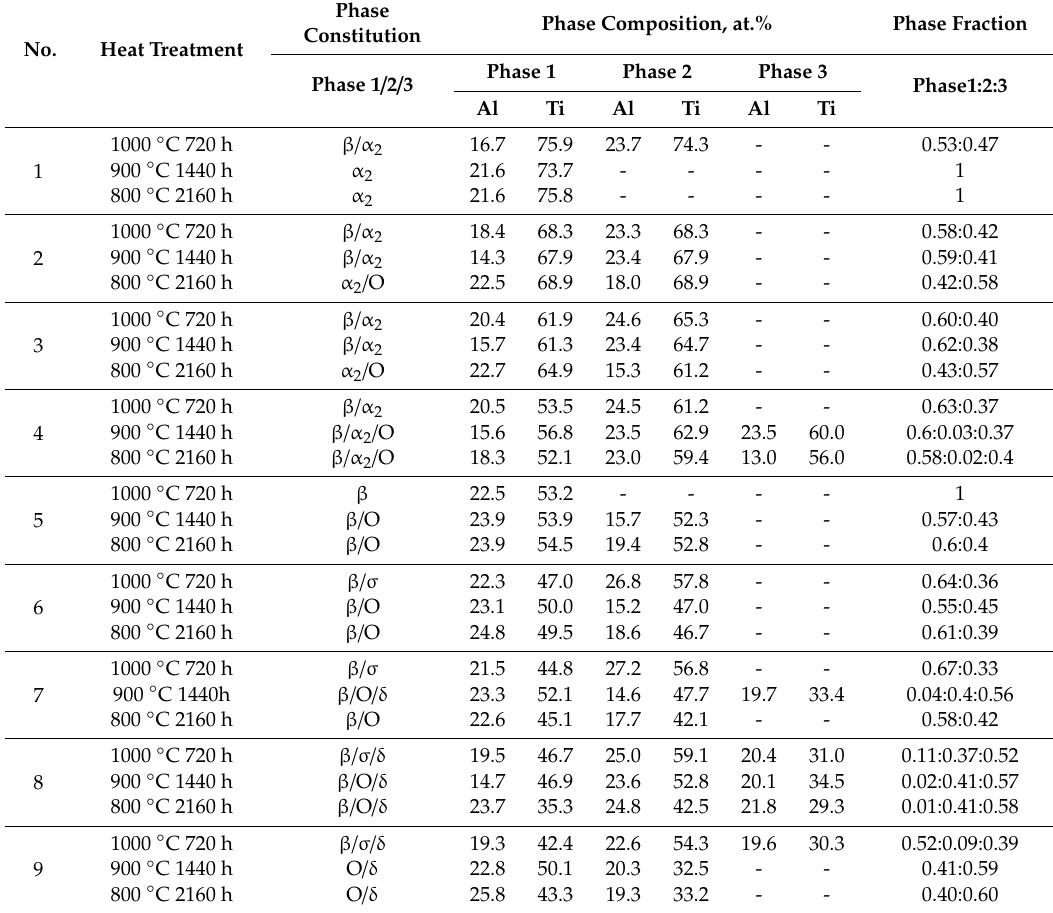
Table 3. Equilibrium compositions and phases determined in the present